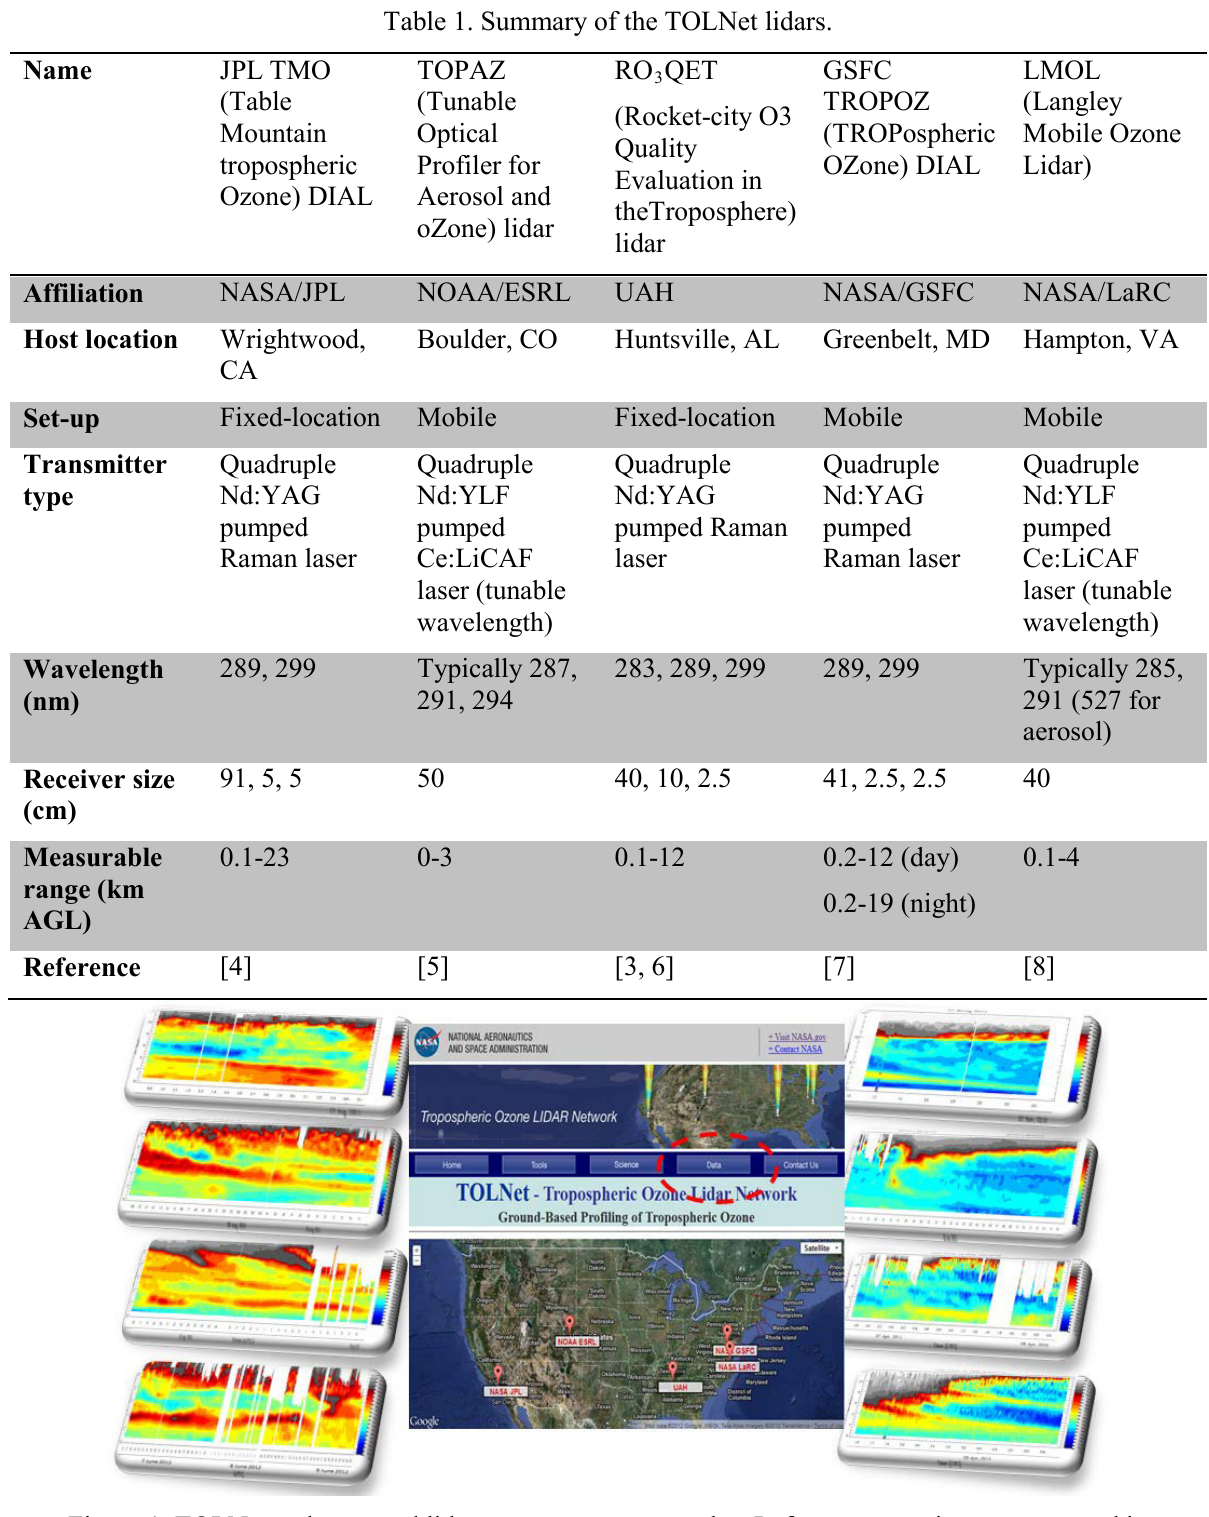
Figure 1. TOLNet webpage and lidar measurement examples. Left ozone curtains are measured in summer and the right curtains are measured in